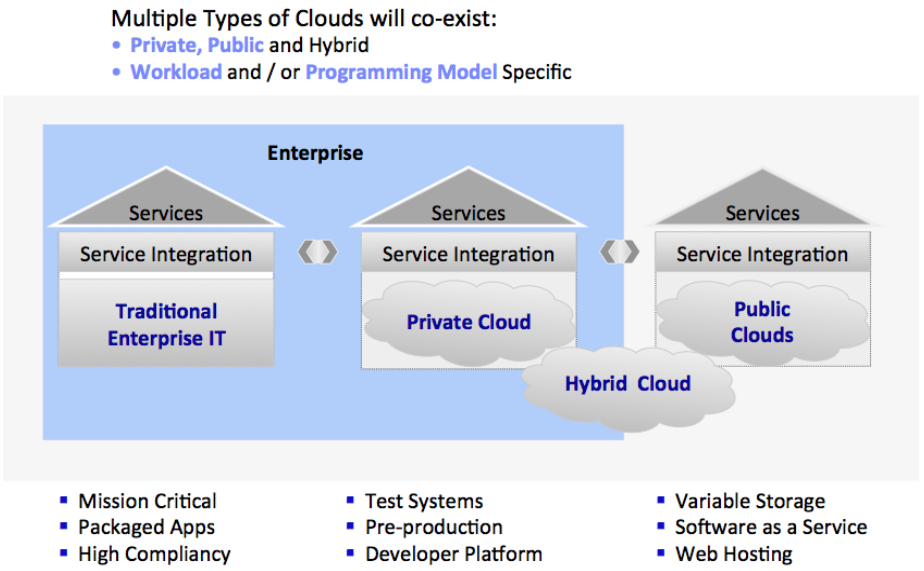
Fig. 3. IT deployment models in the